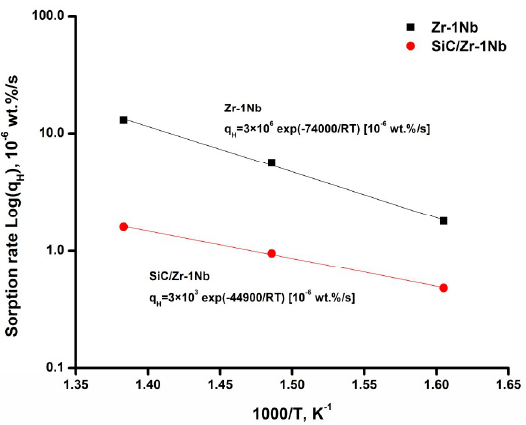
Figure 4. Arrhenius plot for hydrogen sorption tests of Zr-1Nb and SiC/Zr-1Nb